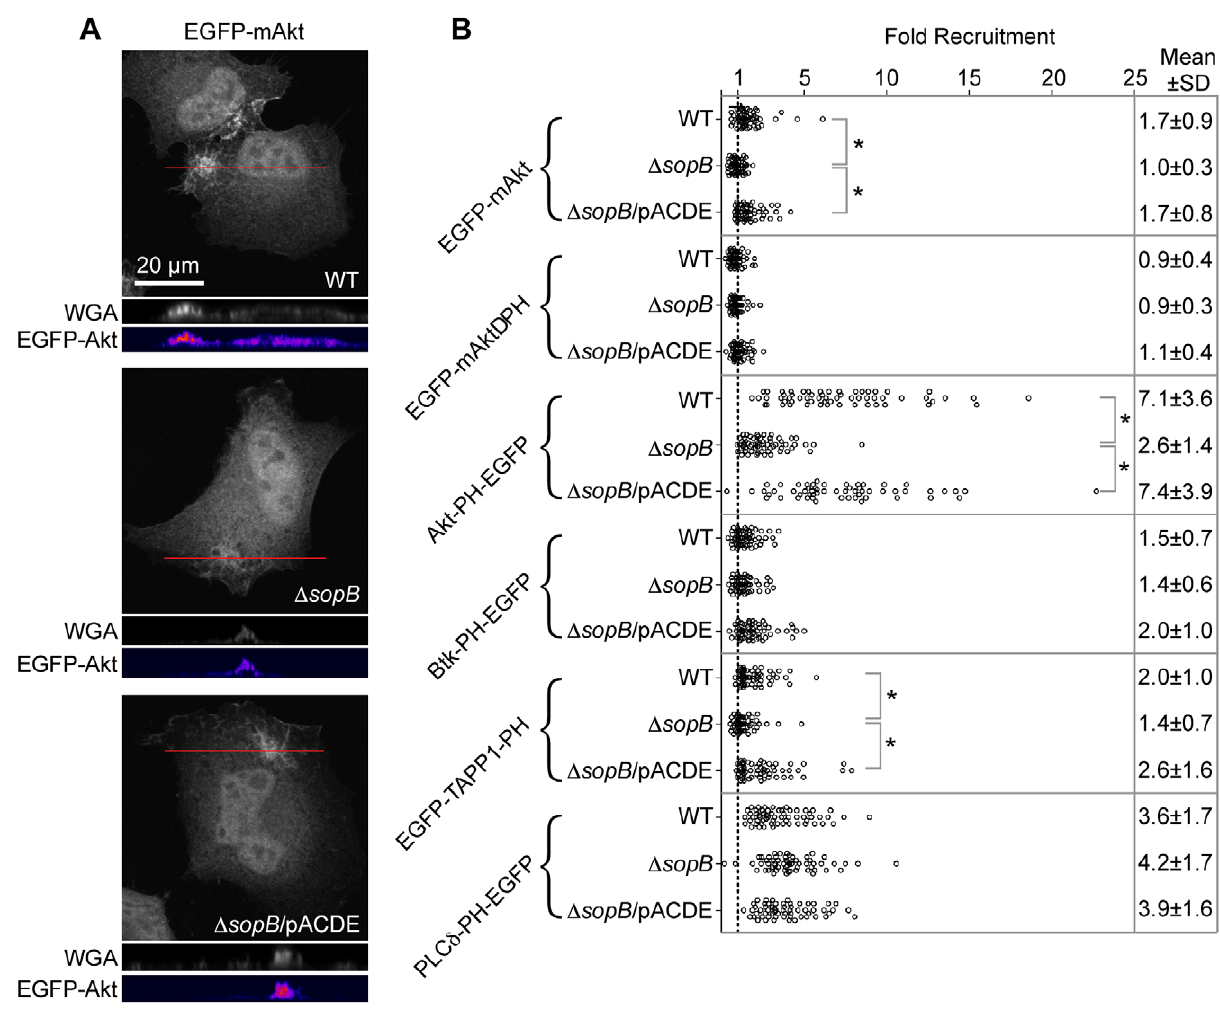
Figure 7. Enrichment of PH domain lipid-binding probes in Salmonella -induced ruffles. HeLa cells transfected with plasmids encoding EGFP-fusions to full length Akt (EGFP-mAkt) or isolated PH domains as indicated were infected with Salmonella for 30 min, then fixed and processed for immunofluorescence microscopy. Cells were stained for plasma membrane (Cy5-WGA) and Salmonella LPS (AF568). (A) Representative images to show EGFP-mAkt accumulation in ruffles induced by Salmonella WT, the D sopB mutant or D sopB complemented in trans with sopB (pACDE). Orthogonal sections show WGA (grayscale) and EGFP-Akt (grayscale converted to a heatmap using the ‘‘FIRE’’ look up table of ImageJ) corresponding to the red lines on the projections. (B) Analysis of GFP fusion enrichment in membrane ruffles. Shown is combined data from three independent experiments. Each dot represents one ruffle. P values were obtained by ANOVA and Tukey’s post hoc analysis (* P , 0.05).